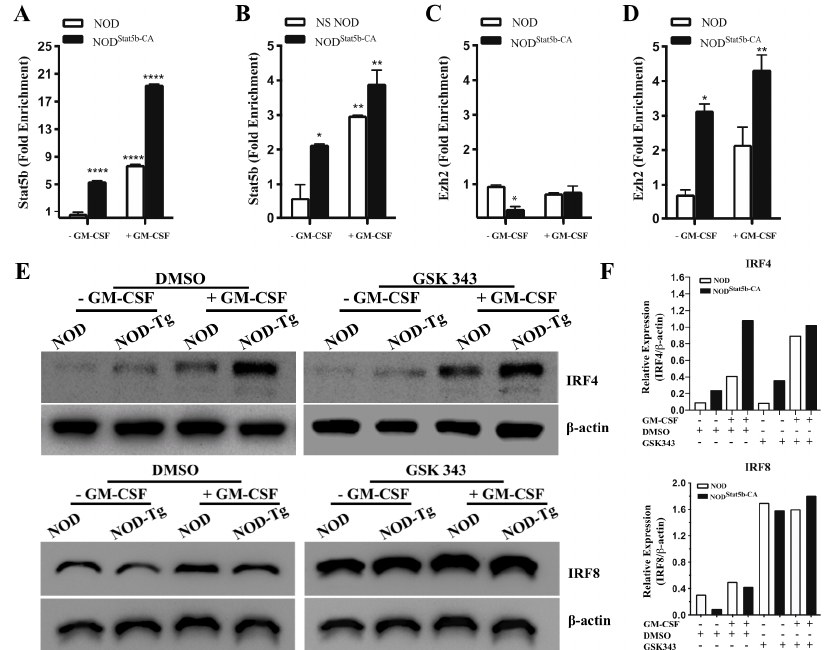
Figure 5. Ezh2 recruitment to upstream sequences of Irf8 gene but not to the promoter of Irf4 genes in BMDCs of NOD and NOD.CD11c Stat5b-CA mice. BMDCs derived from NOD and NOD.CD11c Stat5b-CA mice were cultured in the absence or presence of GM-CSF (50 ng / mL) for 48 h. ChIP experiments were performed using antibodies against ( A , B ) Stat5b or ( C , D ) Ezh2. DNa fragments of Irf4 ( A , C ) and Irf8 ( B , D ) were quantified by qPCR. IgG was used as a negative control. ( E , F ) BMDCs were pre-incubated for 1 h with the Ezh2 inhibitor GSK343 (3 µ M) or vehicle (0.1% DMSO) prior to cultures being continued for 48 h in the absence or presence of GM-CSF (50 ng / mL). ( E ) Expression of IRF4 and IRF8 was analyzed by Western blot. ( F ) Quantitative data in Figure 5E normalized to loading control ( β -actin). Data are shown as the mean ± SEM. The asterisks indicate statistically significant di ff erences determined by one-way ANOVa with Tukey’s post-test. p < 0.05 (*), p < 0.01 (**), and p < 0.0001